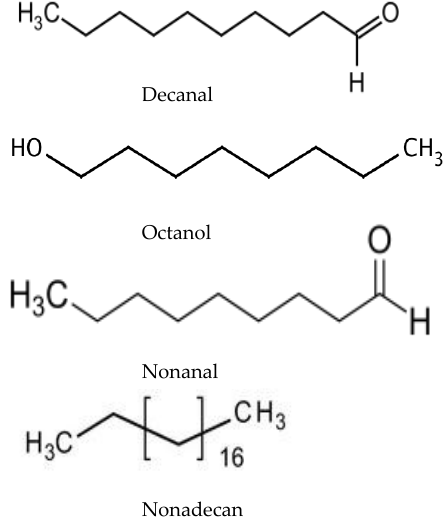
ne Figure 7. Components of the Acacia essential Figure 7. Components of the Acacia essential oils.